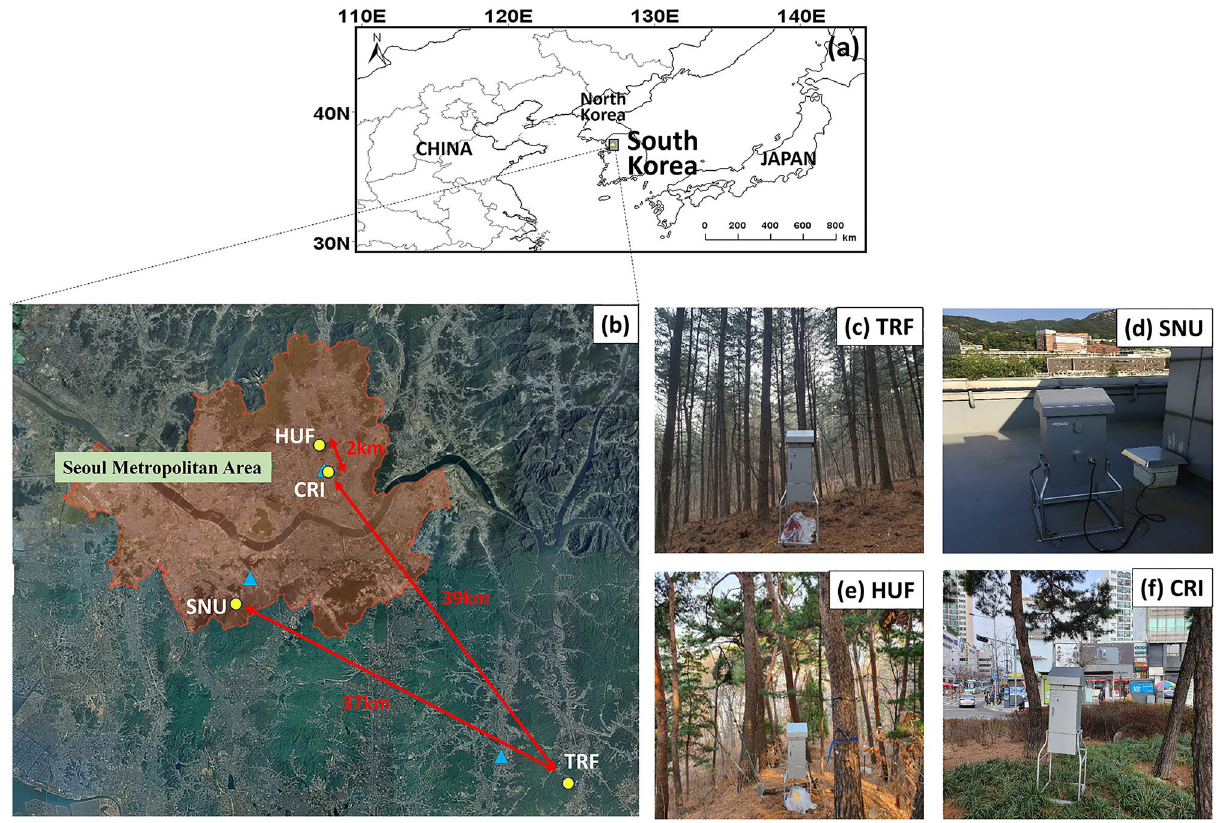
Figure 1. ( a ) The location of study sites in South Korea, ( b ) PM 2.5 sampling points for high-volume air sampler (yellow circles) and the national PM 2.5 monitoring sites (blue triangles). The high-volume air sampler was set at ( c ) the Taehwa Research Forest (TRF), (d ) the Seoul National University (SNU), ( e ) the Hongneung urban forest (HUF) and (f) Cheongnyangni traffic island (CRI). The map of East Asia in ( a ) was created by MeteoInfo 3.5.5 (http:// www. meteo think. org) and the satellite imagery in ( b ) was created on the Vworld platform (http:// map. vworld. kr) provided by the Korean Ministry of Land, Infrastructure and